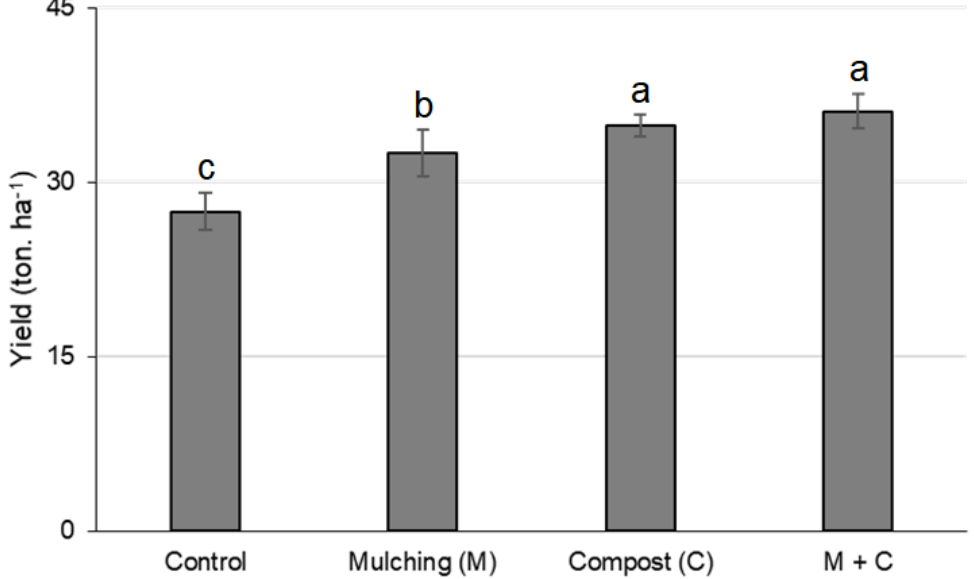
Figure 5. P. pyrifolia yield (ton. ha − 1 ) as affected by different organic residues management in a subtropical ecosystem, Curitibanos, Santa Catarina, Southern Brazil. Different small letters into each line differ by Bonferroni’s test ( p < 0.05). Table 3. Above- and belowground carbon density (t C ha − 1 ), soil organic C stock (t C ha − 1 ), and in a subtropical ecosystem, Curitibanos, Santa Catarina, Southern